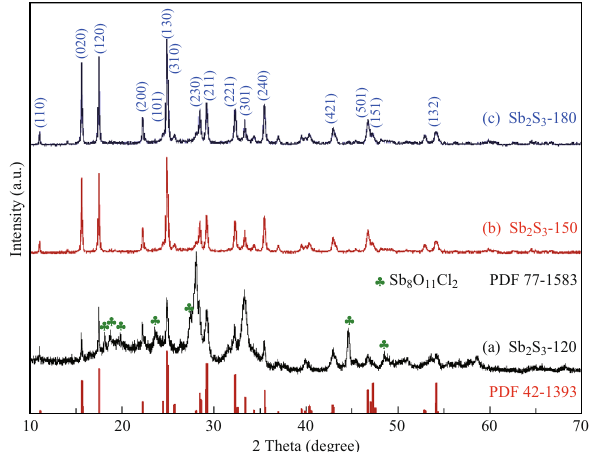
Fig. 1 XRD patterns of as-prepared a Sb 2 S 3 -120, b Sb 2 S 3 -150, and c Sb 2 S 3 -180